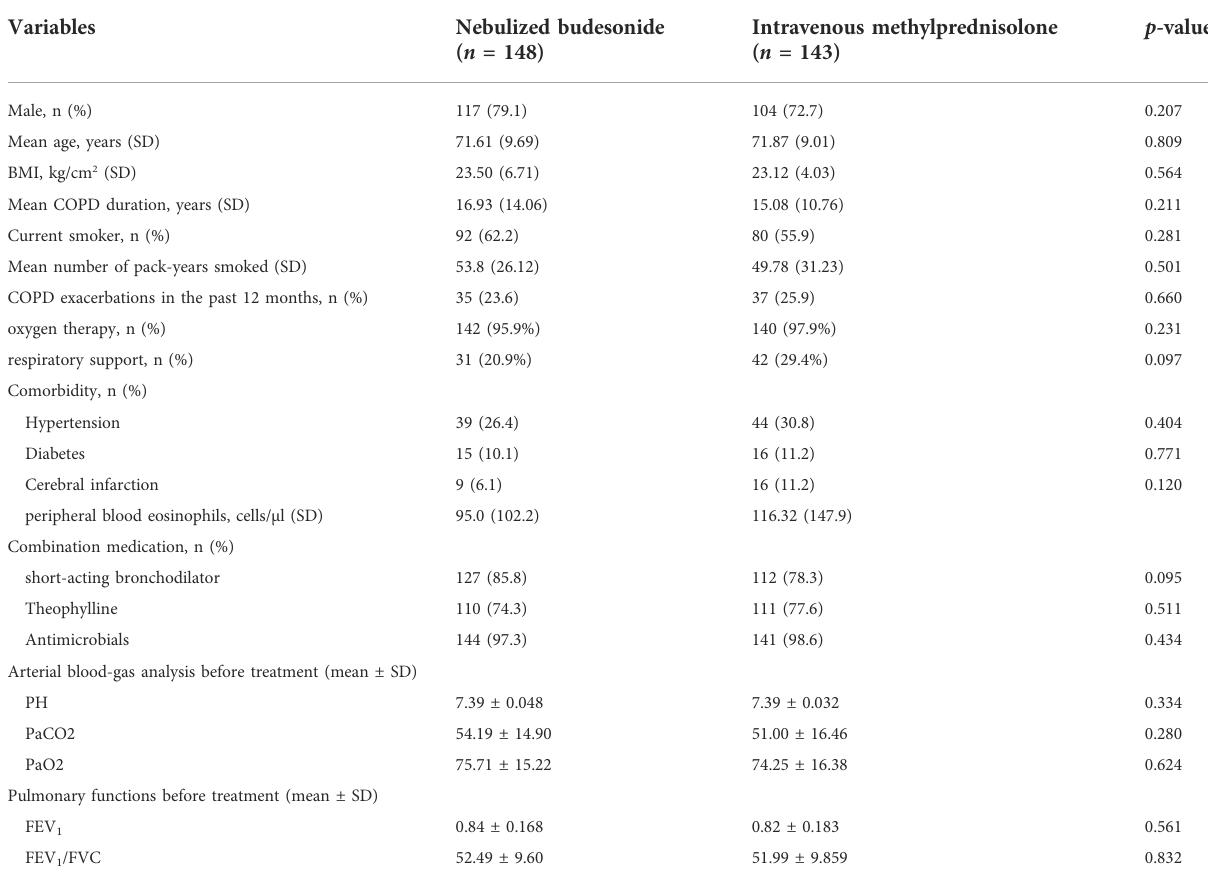
TABLE 1 Baseline